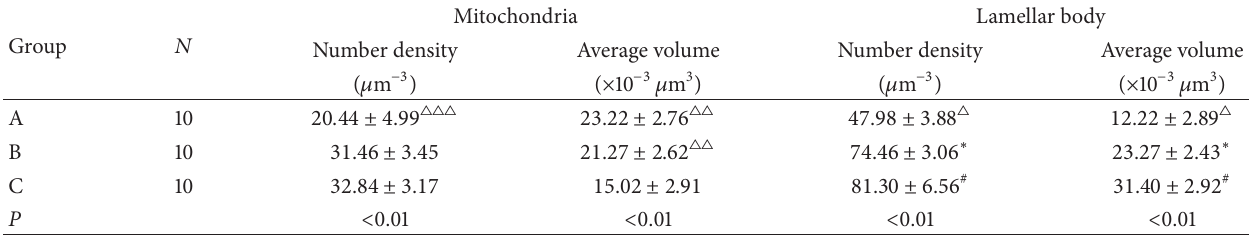
Table 6: Comparison of mitochondria and stereology of lamellar body in type II epithelium in fetal rats of three groups ( 𝑥 ± s ) .